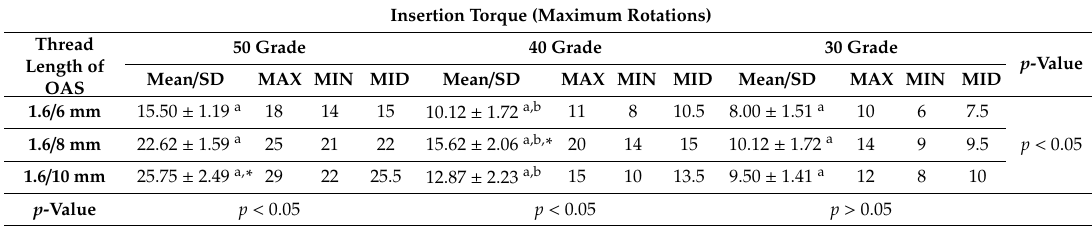
Table 4. Insertion torque values (maximum rotations) measured using the manual anchorage method.